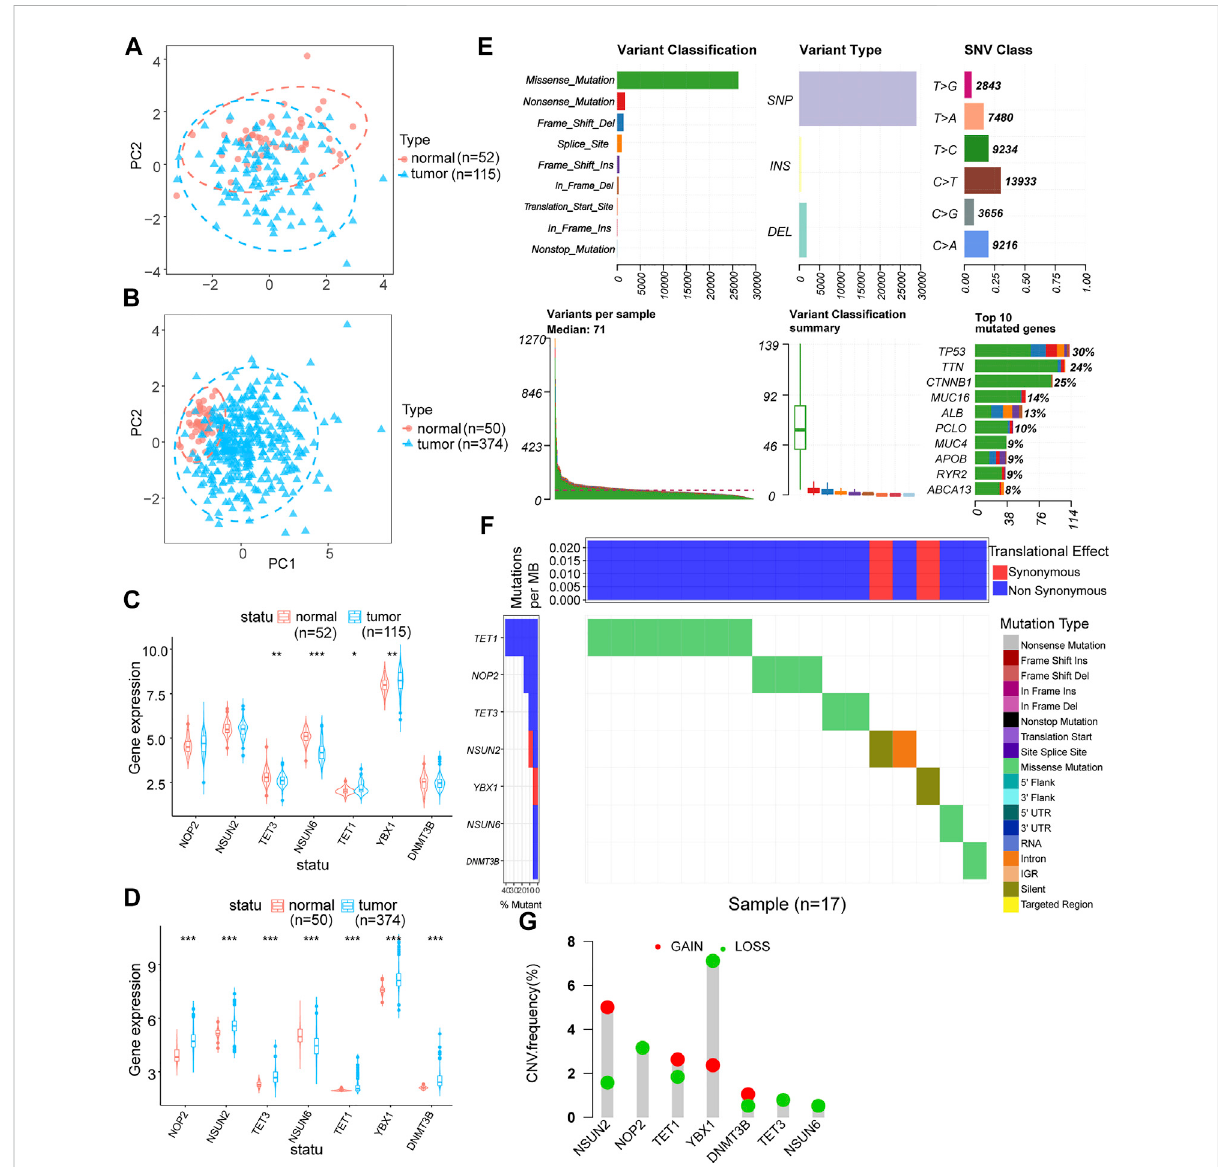
FIGURE 1 m5C regulator genes analysis. (A,B) : PCA analysis of GEO and TCGA expression matrices after data correction, blue represents tumor samples (GEO: n = 115, TCGA: n = 374) and red represents control samples (GEO: n = 52, TCGA: n = 50); (C,D) : differential expression analysis of m5C regulator genes in GEO and TCGA expression matrices after data correction, blue represents tumor samples (GEO: n = 115, TCGA: n = 374) and red represents control samples (GEO: n = 52, TCGA: n = 50); (E) : mutation pro fi le of m5C regulator genes in hepatocellular carcinoma; (F) : m5C- related regulators SNV mutation category and frequency; (G) : m5C regulator genes CNV ampli fi cation and